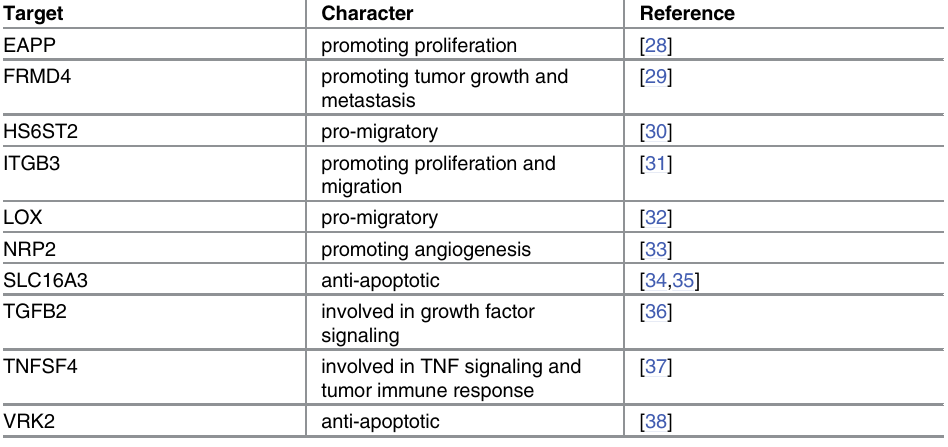
Table 2. Predicted cancer targets of miR-141-3p and miR-145-5p by miRWalk.